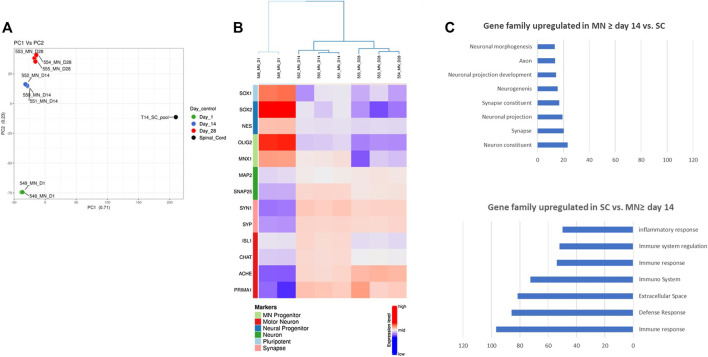
RNASeq analysis of hiPSC-derived Motor Neurons. (A) Principal Component Analysis showing distinct signatures at different time points during maturation of hiPSC-derived Motor neurons and Spinal cord RNA sample. (B) Heat map illustrating the time-course of Motor Neurons progenitors and mature Motor Neurons expression (C) Enrichment analysis showing classes of genes that are over-represented in Motor Neurons after 2 weeks of maturation compared to a human tissue sample (Spinal Cord) and classes of genes that are over-represented over-represented in human spinal cord compared to Motor Neurons after 2 weeks of maturation. Expressions are in ‐logp value. Only the top gene sets of the Gene Ontology collection are represented.